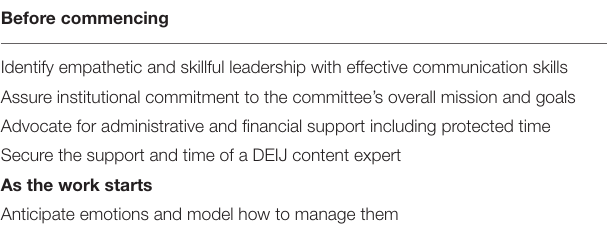
TABLE 3 | Recommendations on the conduct of Diversity Equity Inclusion and Justice (DEIJ)